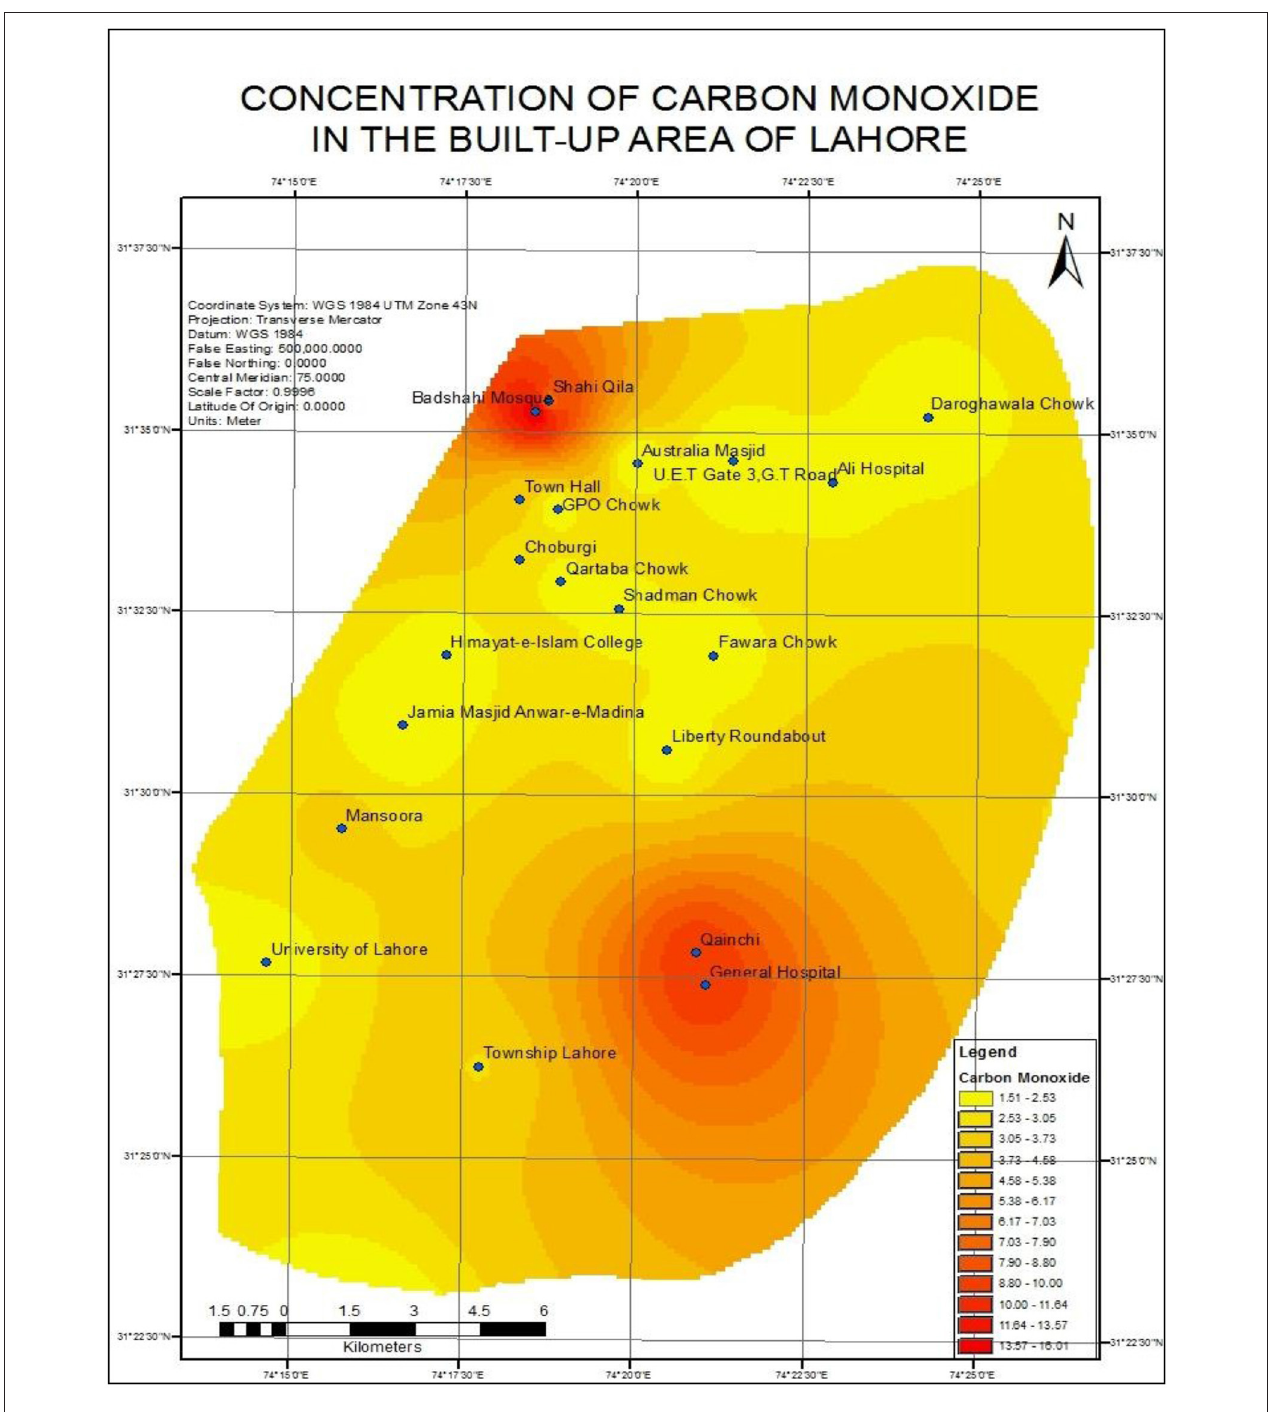
FIGURE 9 | Concentration of carbon